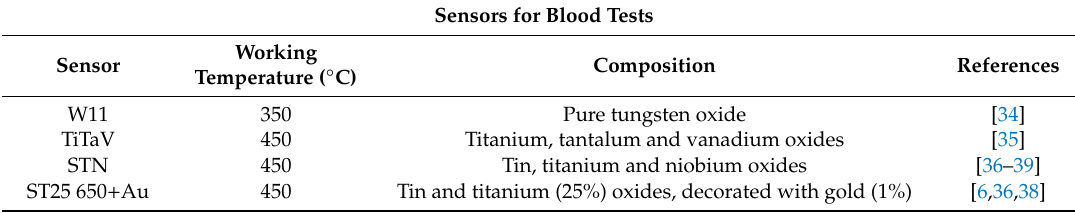
Sensors used for the blood tests, their working temperature, a brief description of their composition, and references to other works in which they are described in depth and their characterizations are